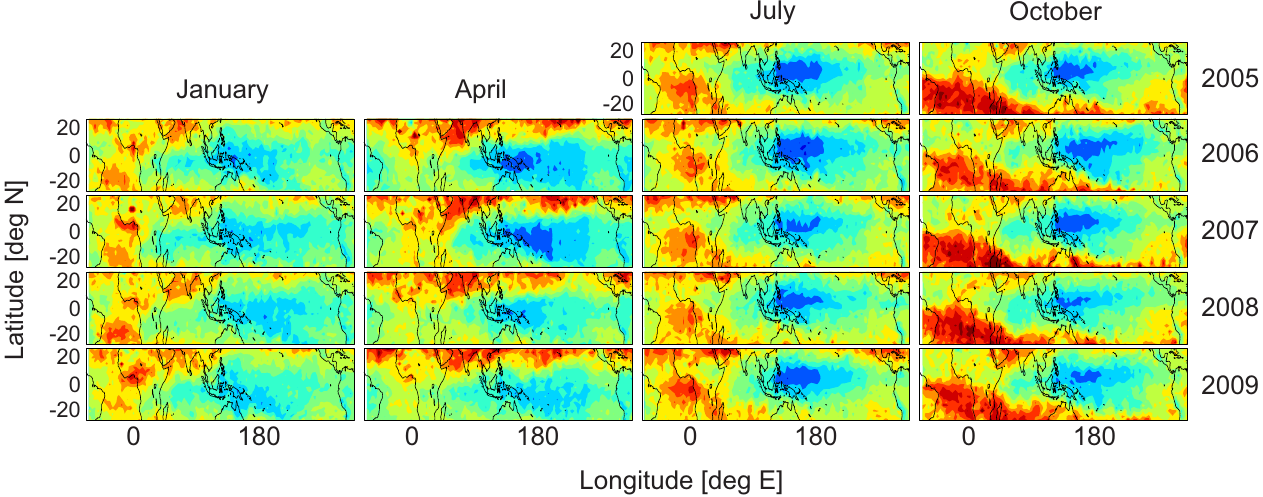
Fig. 5. Monthly mean tropospheric ozone columns from TES for January, April, July and October for the years 2005–2009 as a function of longitude and latitude. Color scale in DU see Fig. 4a.